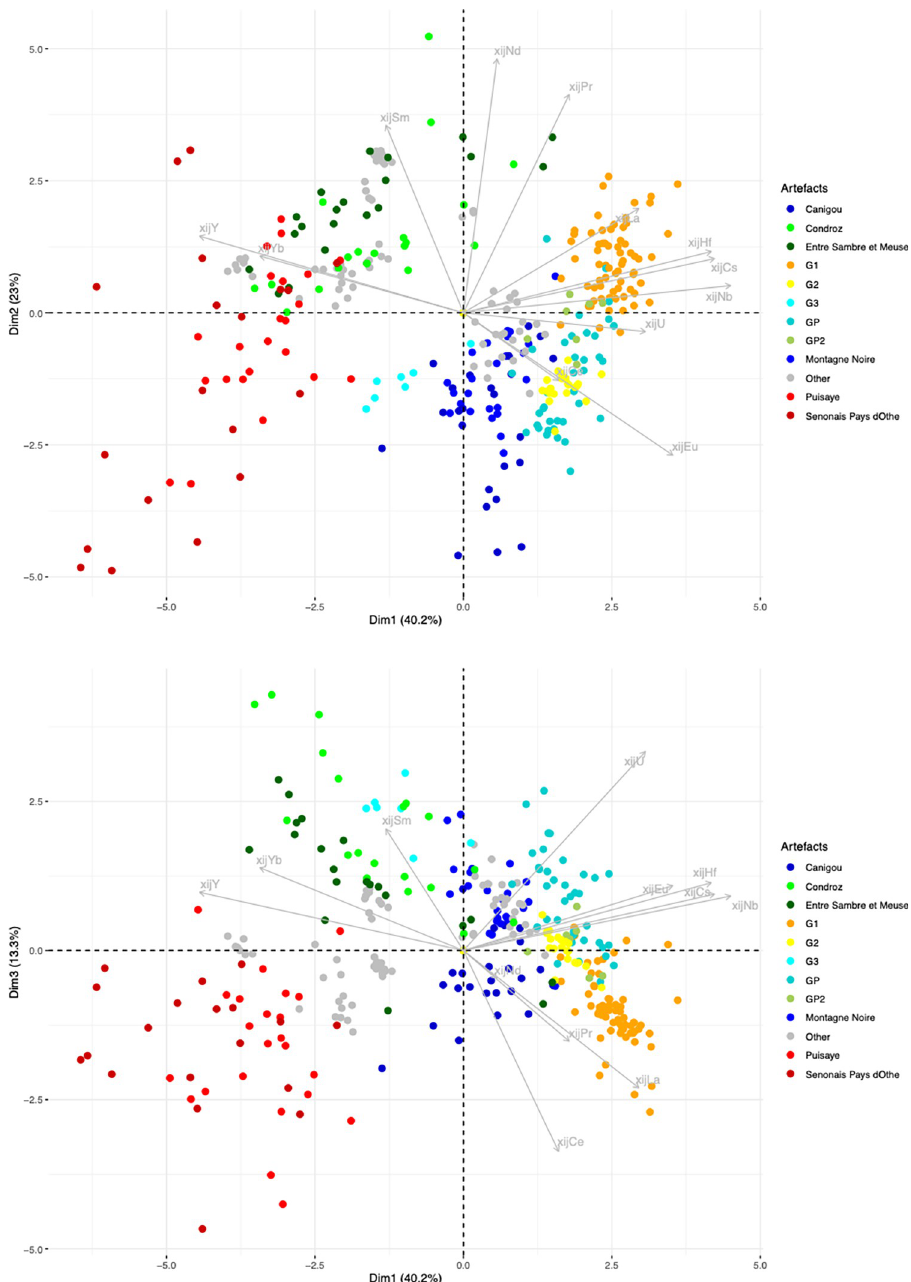
Fig 16. PCA on xij of production area slag. Artefacts not consistent with the production areas are highlighted. % between brackets: % of total variance.